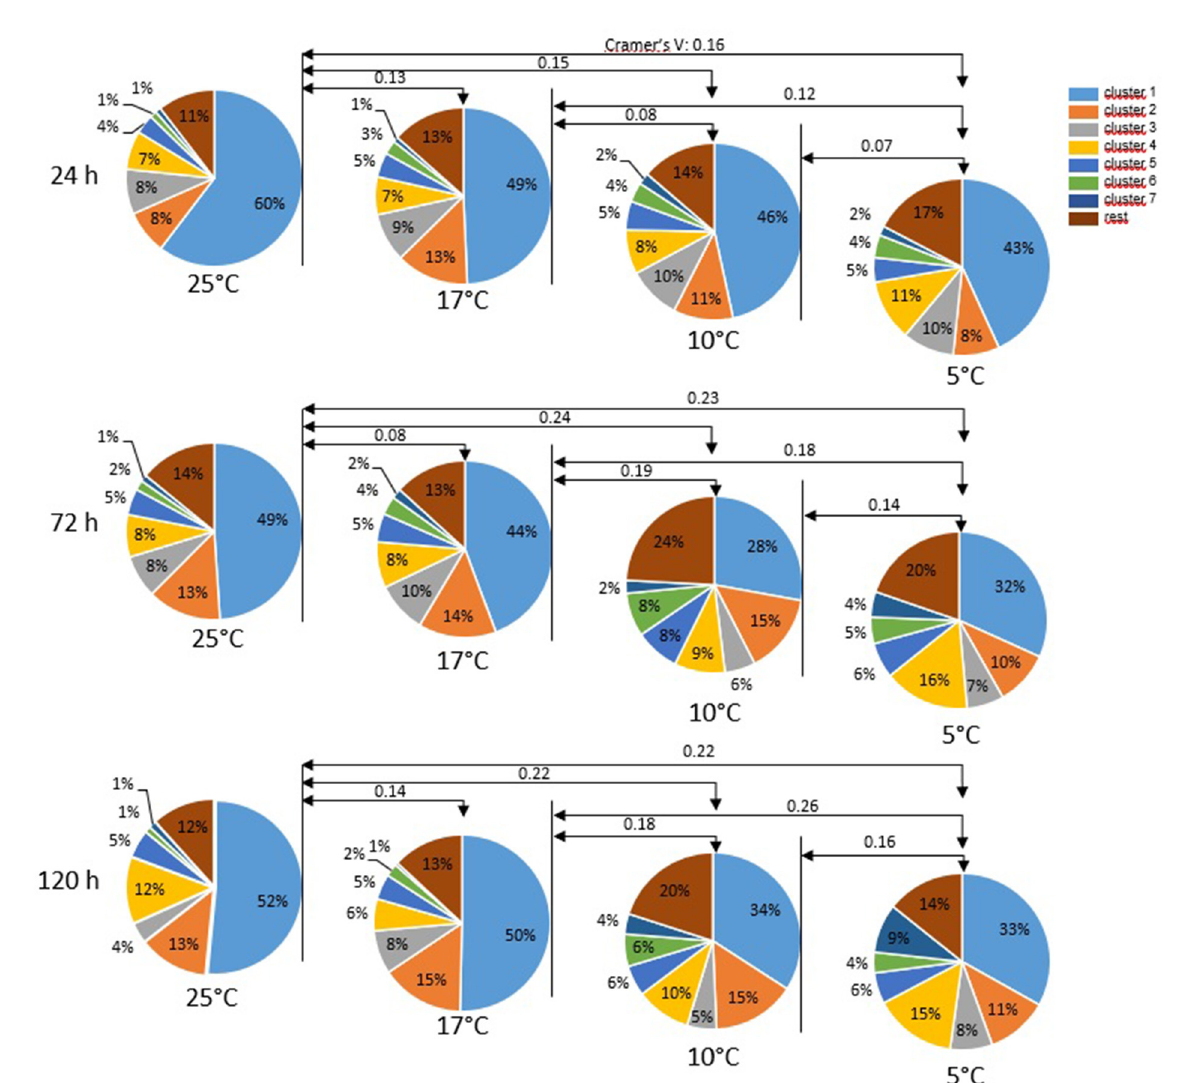
FIGURE3 Motility patterns (cluster) of sperm after different storage times at different temperatures. Single sperm data derived from computer-assisted semen analysis (CASA; n = 33,229 spermatozoa) were subjected to cluster analysis. Data from all semen storage temperatures and times were combined. Cluster analysis provided a solution with seven main clusters, which explains 68.9 % of the variance in the dataset. Only clusters containing at least at any one time by temperature combination 5% of the spermatozoa are depicted. For motility characteristics of the individual cluster, (see Table 1). Values on arrow lines present Cramer’s V which indicates the effect size of storage temperature: V < 0.10 = no effect, 0.10 < V ≤ 0.30 = small effect, 0.30 < V ≤ 0.50 = moderate effect, V > 0.50 = strong effect.